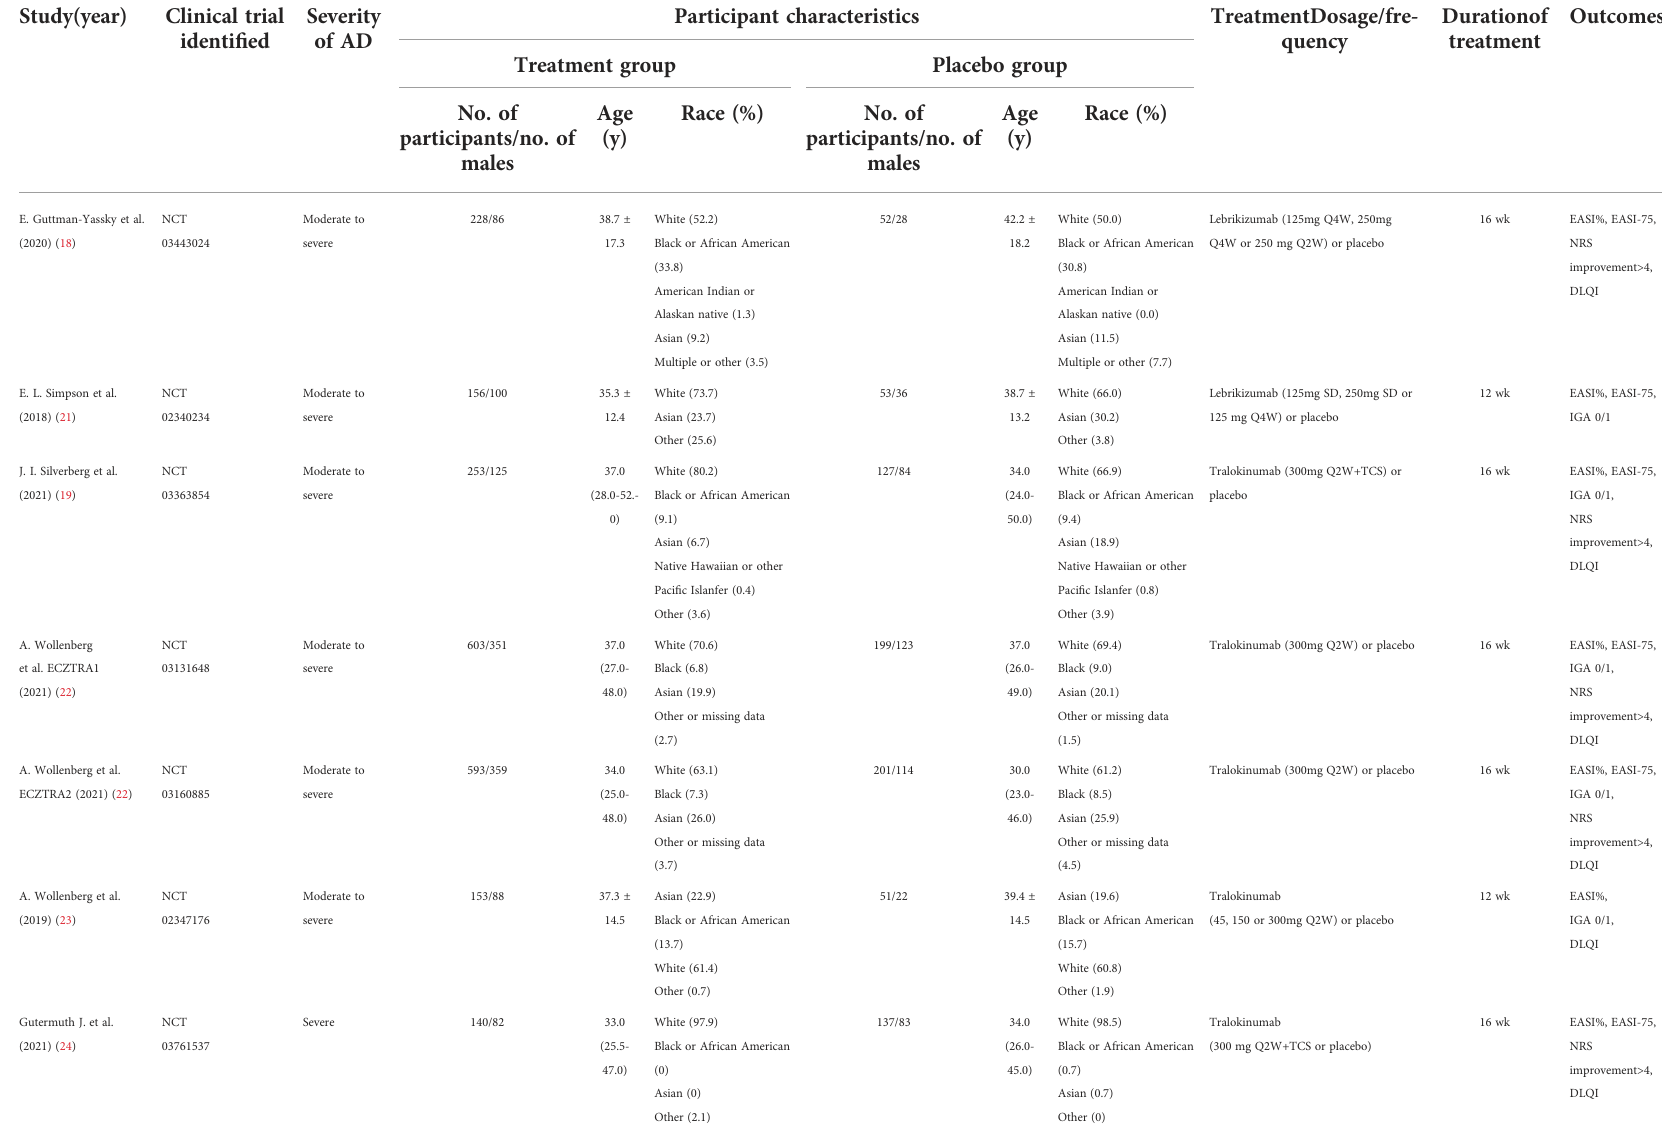
TABLE 1 Characteristics of the included studies